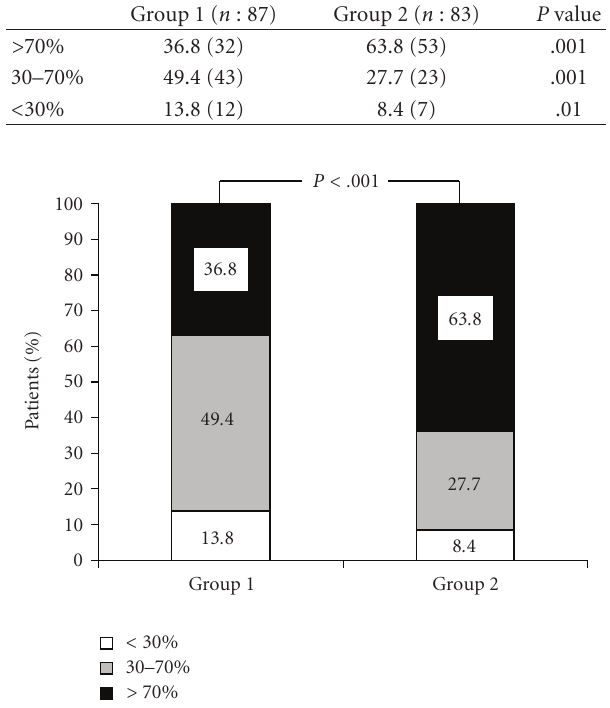
Figure 1: 120 minute ST-segment resolution.